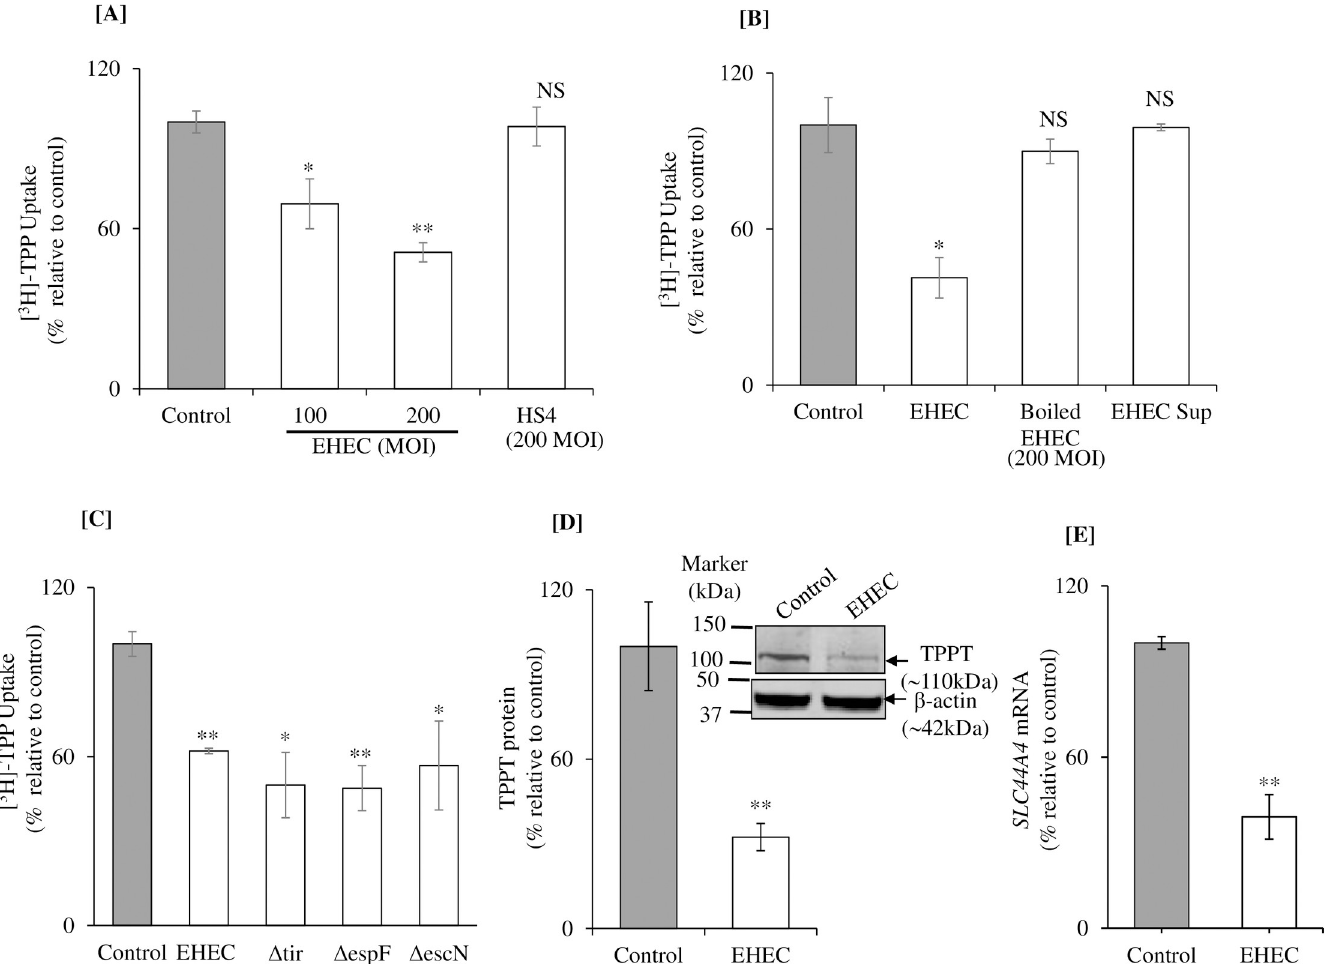
Fig 1. Effect of EHEC infection of human colonic epithelial NCM460 cells in vitro on carrier-mediated TPP uptake and on level of expression of TPP transporter (TPPT). [A] Carrier-mediated [ 3 H]-TPP uptake was examined in NCM460 cells infected with EHEC at 100 and 200 MOI for 5 h. [B] Carrier-mediated TPP uptake was examined in NCM460 cells exposed to boiled (heat-killed) EHEC or bacterial culture supernatant. [C] Effect of infection with EHEC mutants ( Δ tir-EHEC, Δ espF-EHEC and Δ escN-EHEC) on [ 3 H]-TPP uptake by NCM460 cells. [D] Levels of TPPT protein expression was examined in NCM460 cells infected with EHEC at 200 MOI for 5 h (by western blotting). Data were normalized with β -actin. [E] Levels of SLC44A4 mRNA expression was examined in NCM460 cells infected with EHEC at 200 MOI for 5h (by RT-qPCR). Data are mean ± SE of 3–4 sets of independent experiments. �� P < 0.01; � P < 0.05; NS-not significant.